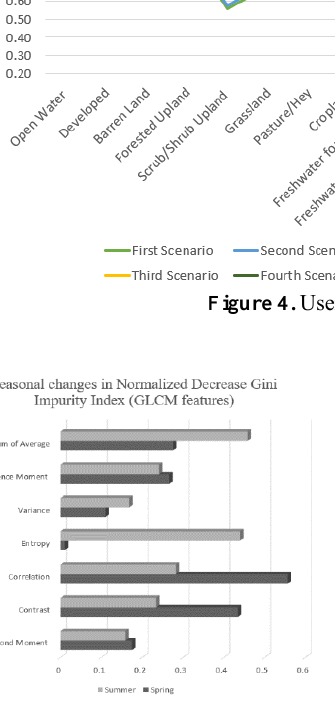
Figure 5. Mean decrease in Gini impurity index of multi- seasonal GLCM features.